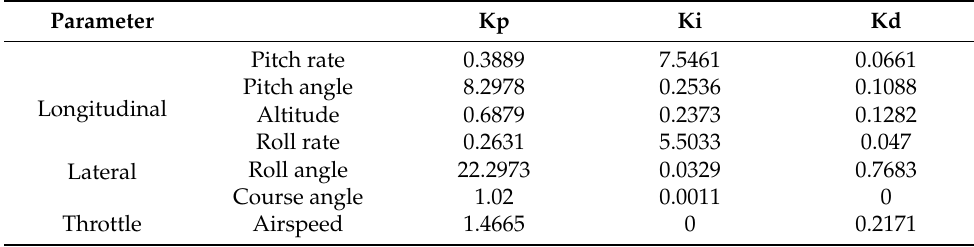
Table A1. Parameters of stability